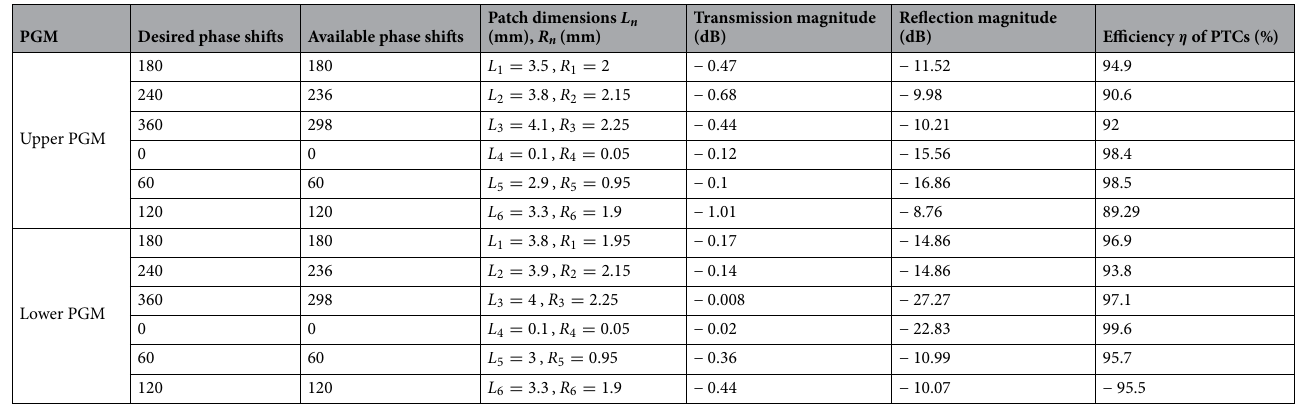
Table 1. Transmission and reflection characteristics of the PTCs with respect to patch dimension used in upper and lower PGM design.